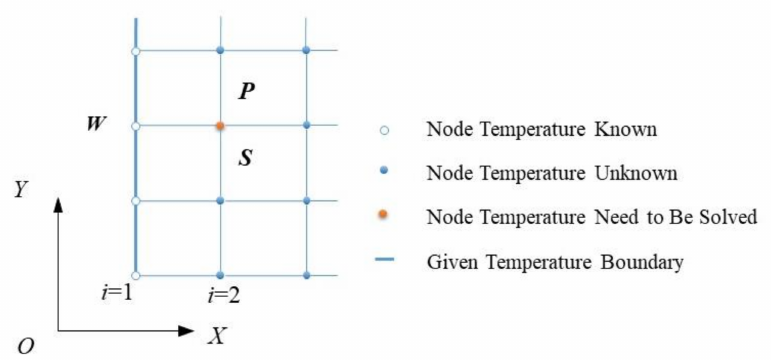
Figure 2. Temperature computational grid and boundary conditions.